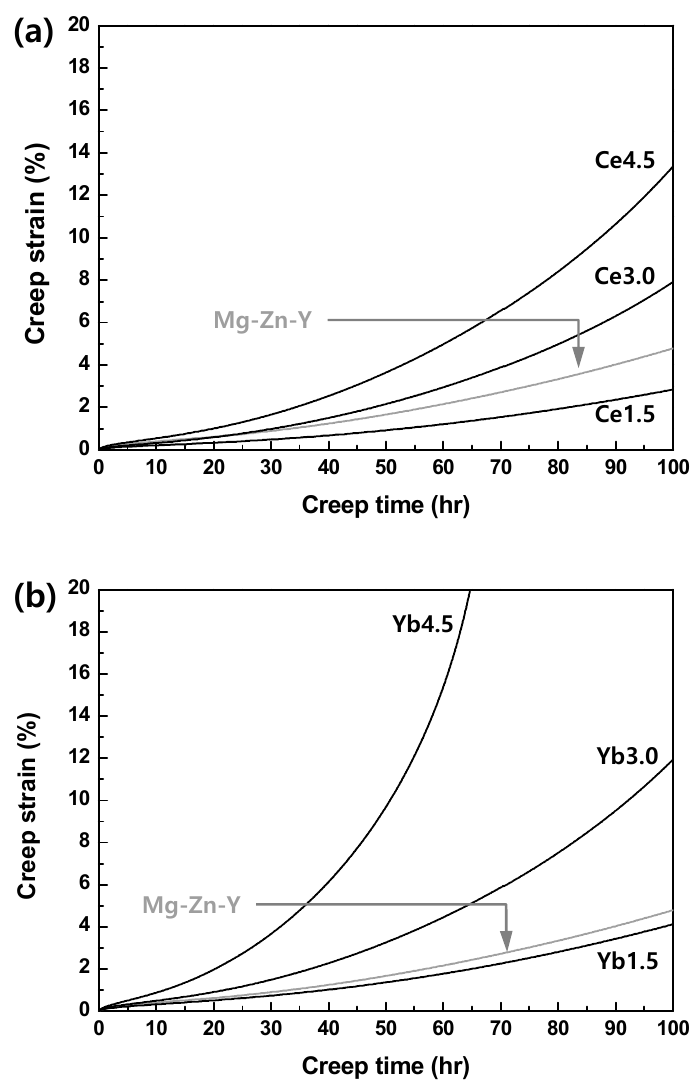
Figure 8. Creep curves of the extruded alloys: ( a ) Mg-Zn-Y-Ce alloys, and ( b ) Mg-Zn-Y-Yb alloys, as measured at 200 °C and 150 MPa.